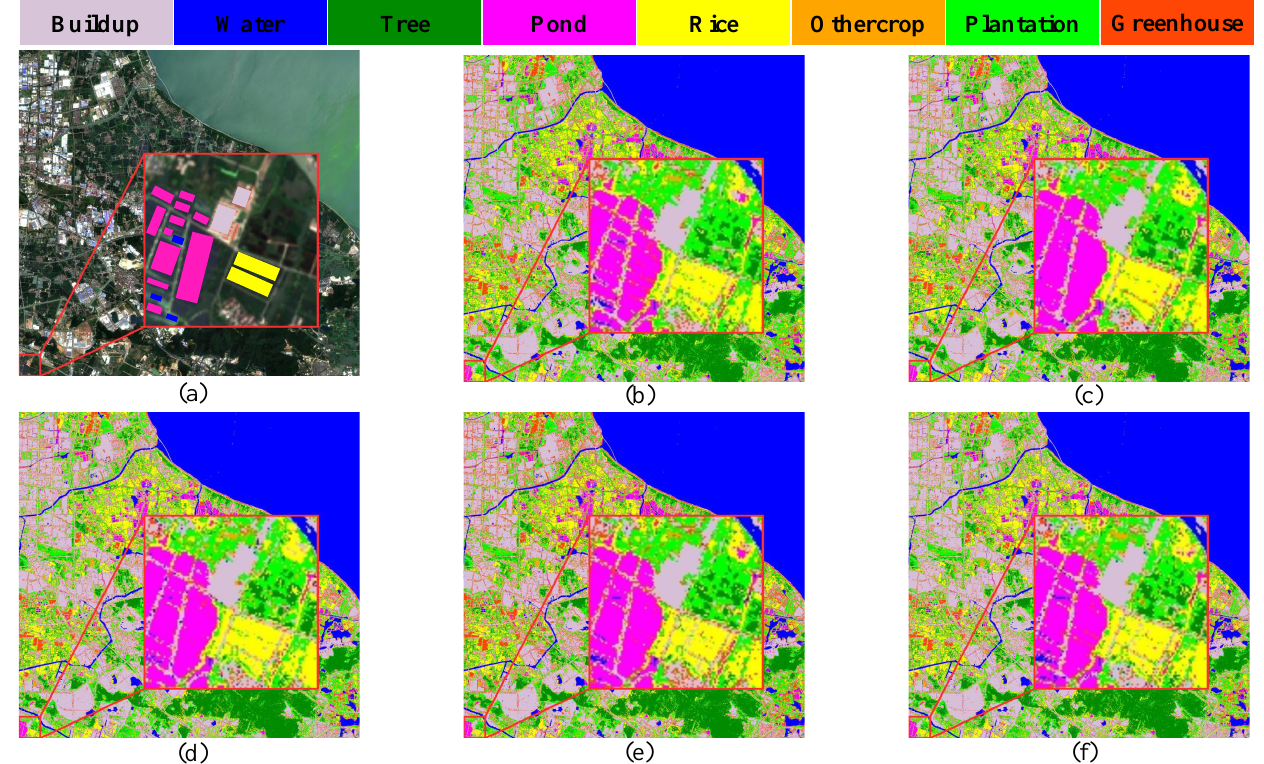
Figure 7. Plot of the classification results of the Changxing County’s dataset using HyFormer with different module combinations: ( a ) Image; ( b ) Transformer (ViT); ( c ) FC + CNN; ( d ) HyFormer (ViT + CNN); ( e ) HyFormer (SC); and ( f ) HyFormer (ViT + CNN +